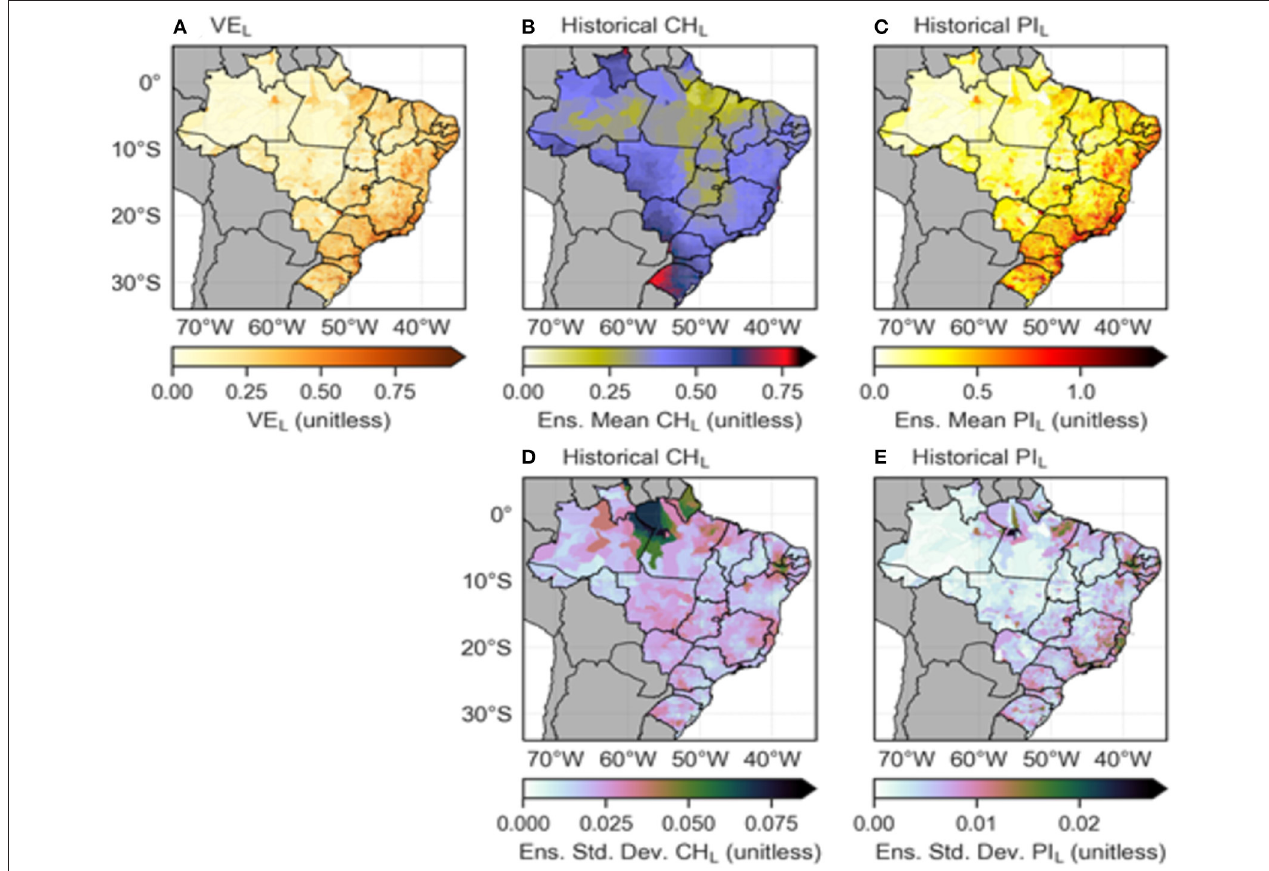
FIGURE 2 | Geographical distribution of (A) the vulnerability-exposure index for landslides (VE L ), (B,D) the ensemble mean and standard deviation of the historical climatic hazards index for landslides (CH L ), respectively. Maps (C) and (E) shows the ensemble mean and standard deviation of the historical potential impact index for landslides (PI L